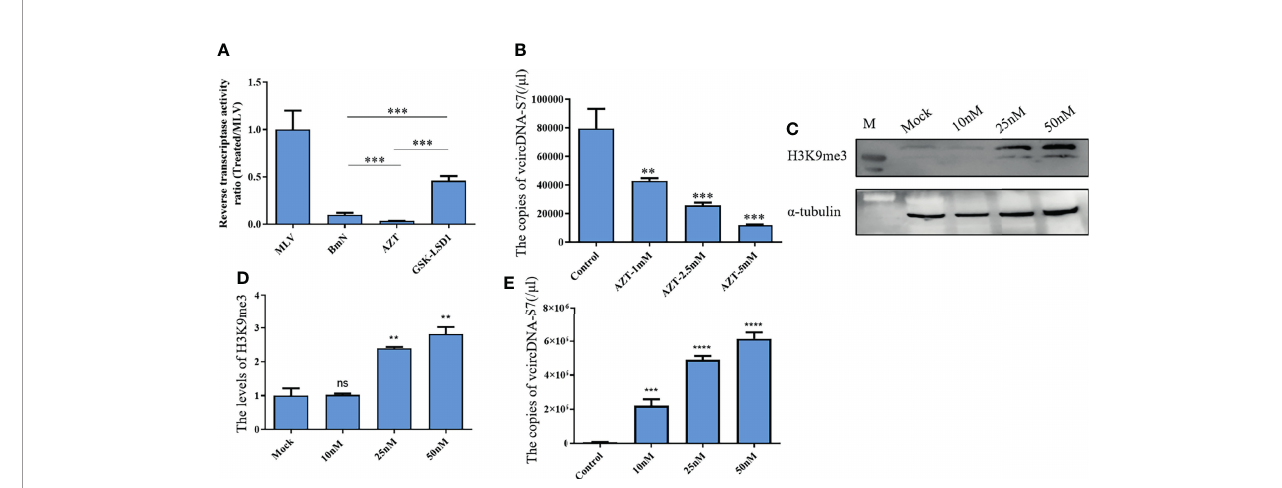
FIGURE 2 | Reverse transcriptase activity is involved in the formation of vcDNA-S7. (A) Endogenous reverse transcriptase activity was measured in BmN cells. BmN cells were pre-treated with 5mM AZT or 50nM GSK-LSD1 for 24 h and then the cells were lysed and the reverse transcriptase activity was measured. Relative reverse transcriptase activity was calculated to 1U of commercialized M-MLV reverse transcriptase. (B) Effect of AZT treatment on the formation of vcDNA-S7. 1×10 6 BmN cells were pre-treated with AZT at the indicated concentrations for 24 h and were infected with BmCPV for additional 48 h. The copies of vcDNA-S7 were determined by real- time PCR. (C, D) GSK-LSD1 treatment improved the level of histone H3K9me. 1×10 6 BmN cells were pre-treated with GSK-LSD1 at the indicated concentrations for 24 h. The level of histone H3K9me was analyzed by western blotting (C) . The grayscale of Western blotting signal bands is analyzed by software Image J (D, E) Effect of GSK-LSD1 treatment on the formation of vcDNA-S7. 1×10 6 BmN cells were pre-treated with GSK-LSD1 at the indicated concentrations for 24 h and were infected with BmCPV for another 48 h. The copies of vcDNA-S7 were determined by real-time PCR. (n=4, ** P <0.01; *** P <0.001; **** P<0.0001 ; ns, no signi fi